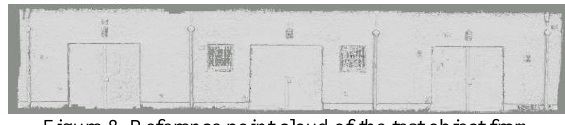
Figure 8. Reference point cloud of the test object from the high resolution NIKON D800 camera